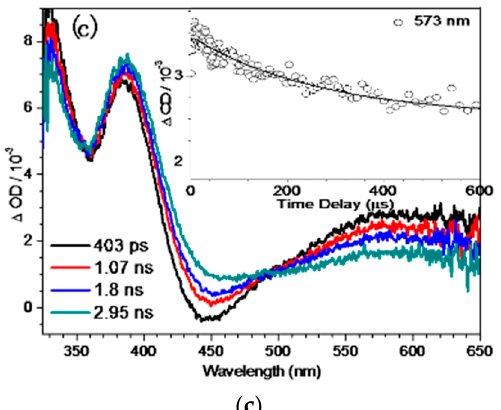
Figure 2. The femtosecond transient absorption (fs-TA) spectra of QMP-b obtained after 266 nm excitation in MeCN:H 2 O (1:1, pH = 12) ( a ) from 1.51 ps to 70 ps, ( b ) from 70 ps to 403 ps, ( c ) from 403 ps to 2.95 ns; inset: kinetics at 573 nm.